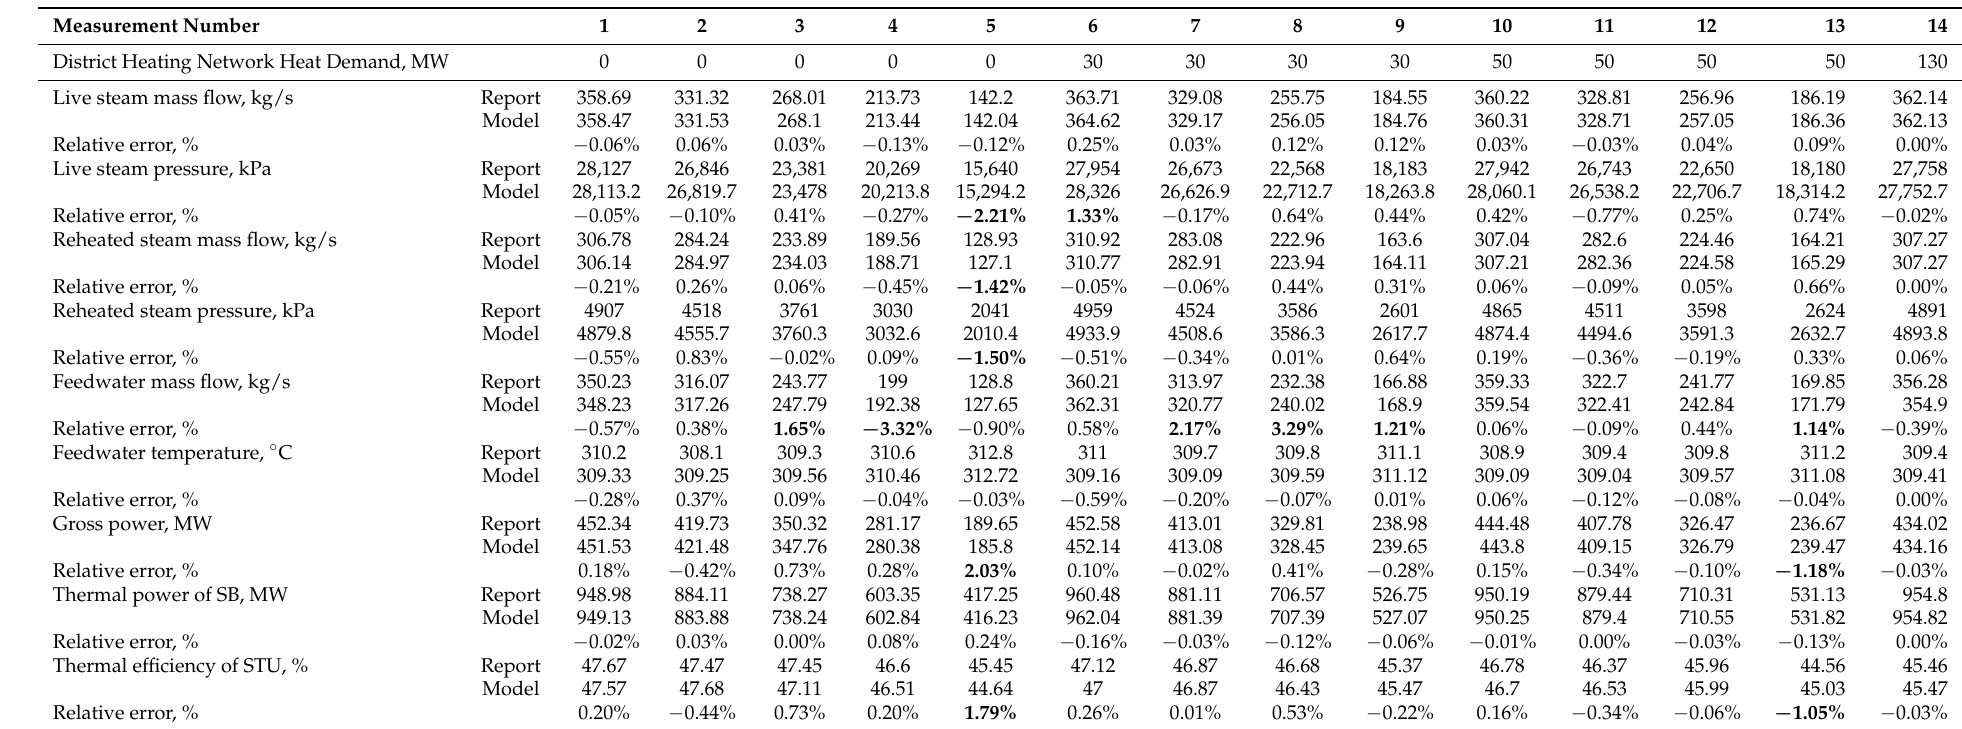
Table A1. Results of validation of steam island